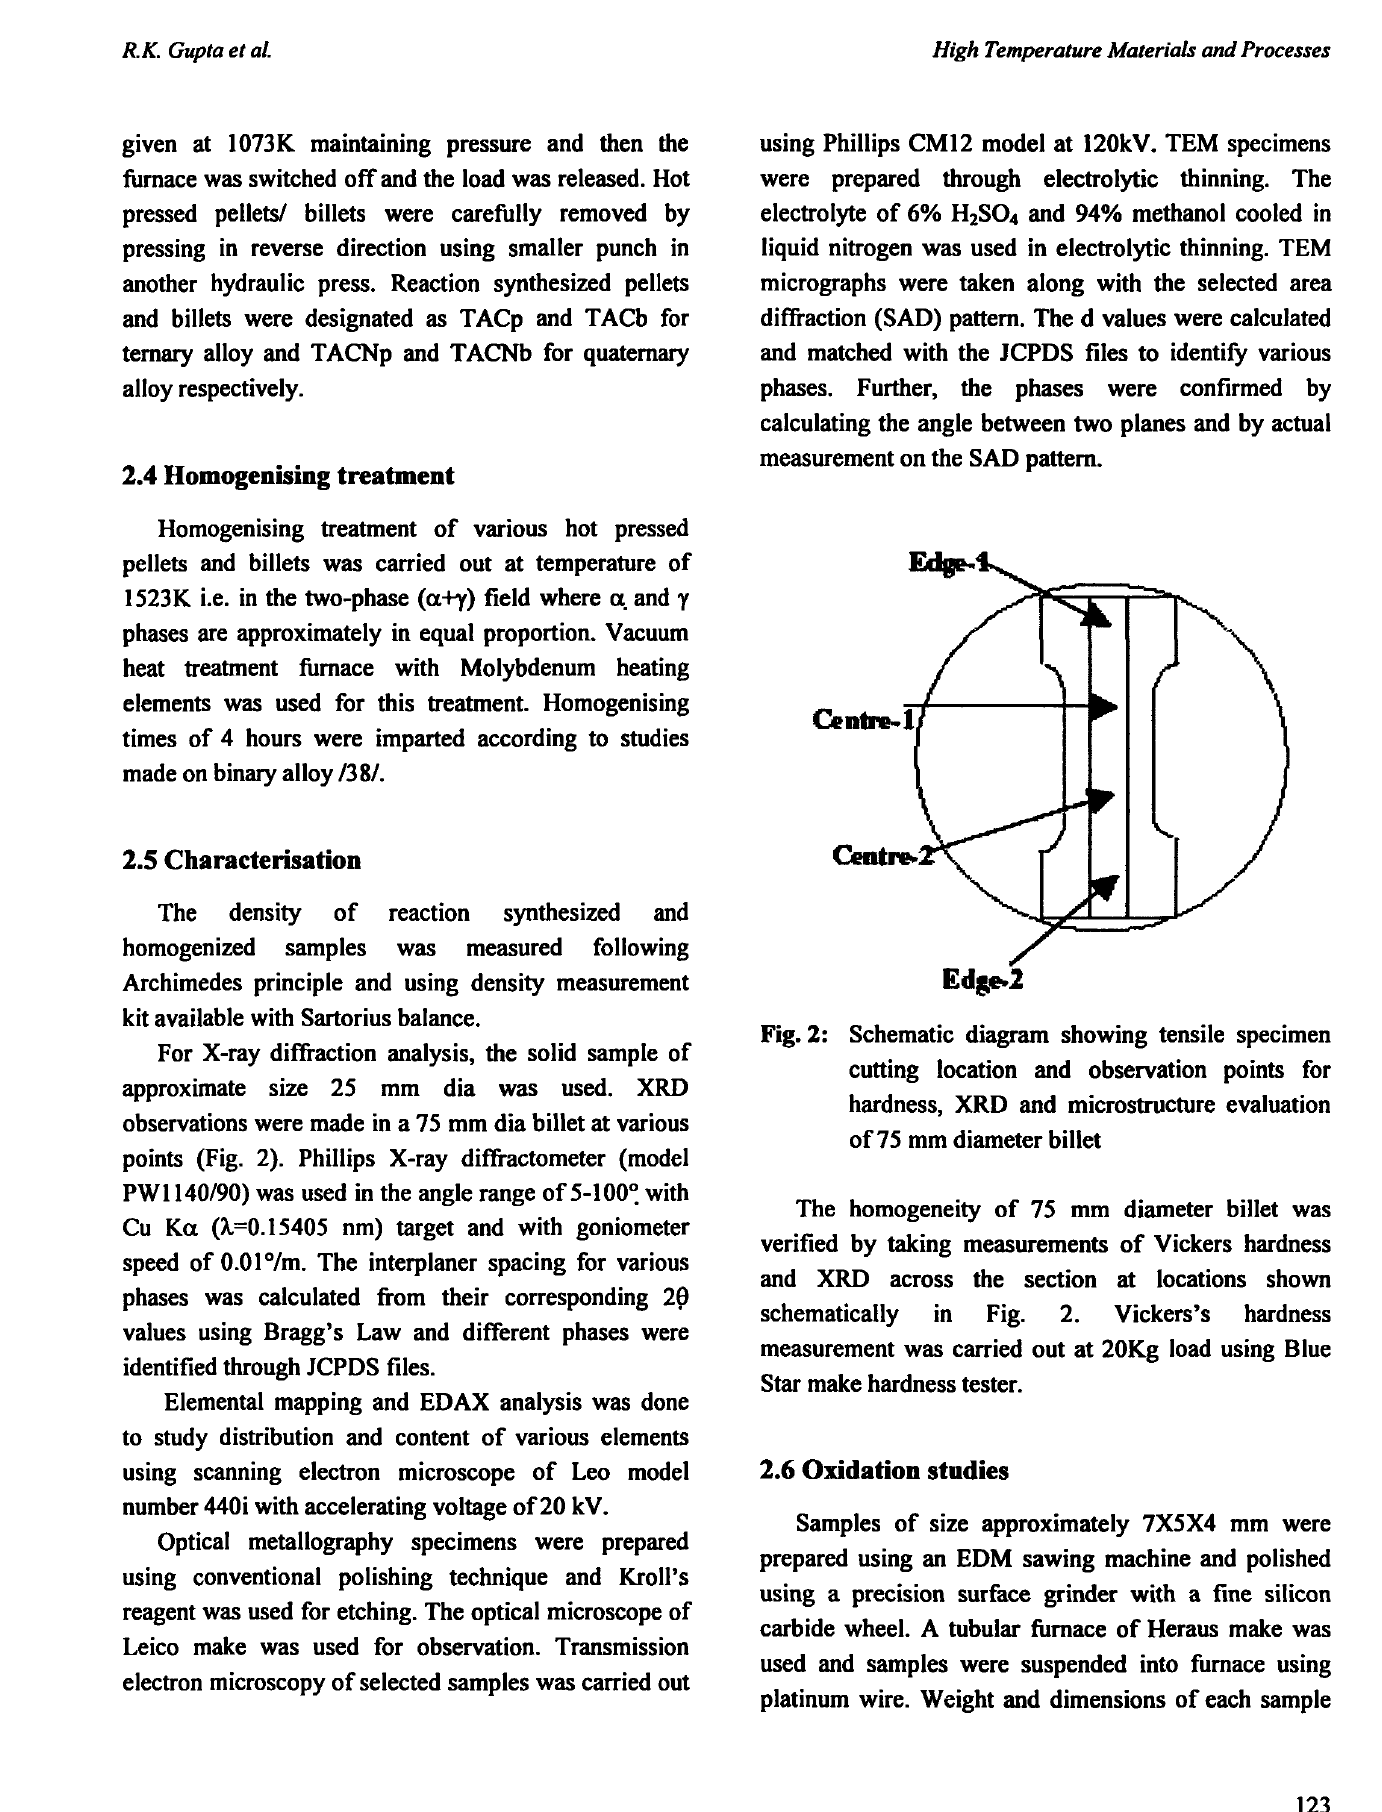
Fig. 2: Schematic diagram showing tensile specimen cutting location and observation points for hardness, XRD and microstructure evaluation of 75 mm diameter billet The homogeneity of 75 mm diameter billet was verified by taking measurements of Vickers hardness and XRD across the section at locations shown schematically in Fig. 2. Vickers's hardness measurement was carried out at 20Kg load using Blue Star make hardness